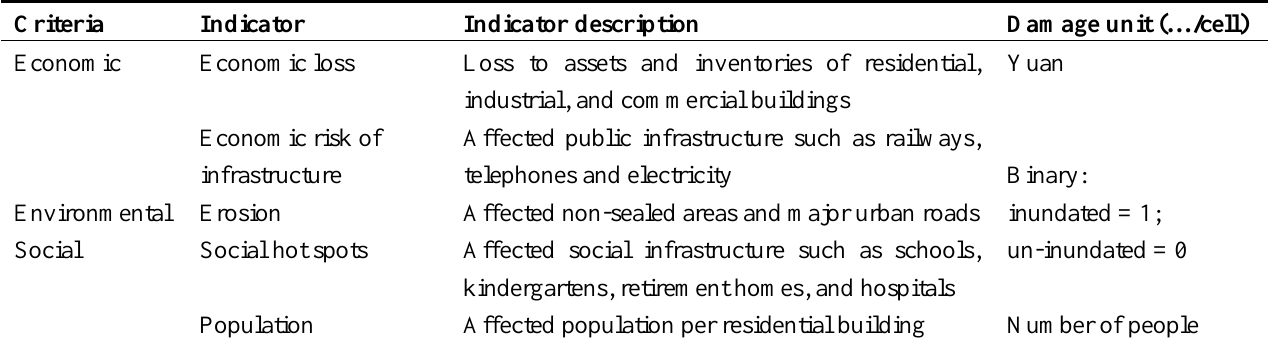
Table 2. Indictor sets for multicriteria flood-risk analyses in the case study.